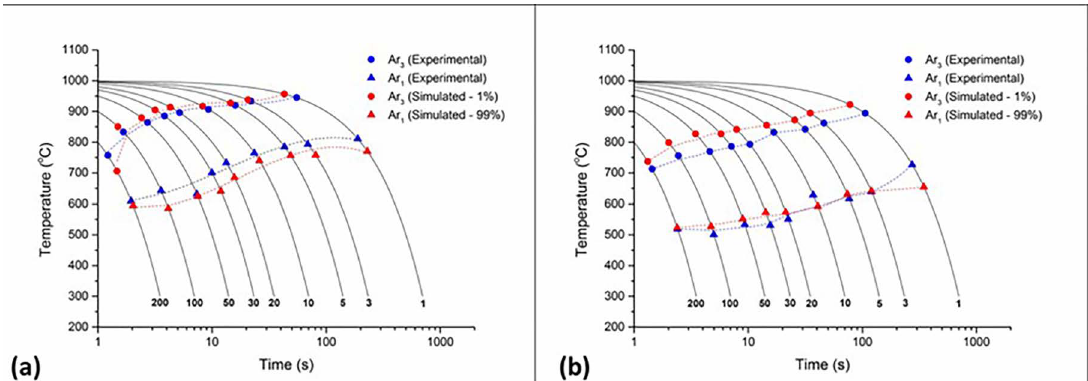
Figure 6. Comparison between experimental and calculated CCT diagrams: (a) steel A, (b) steel B.